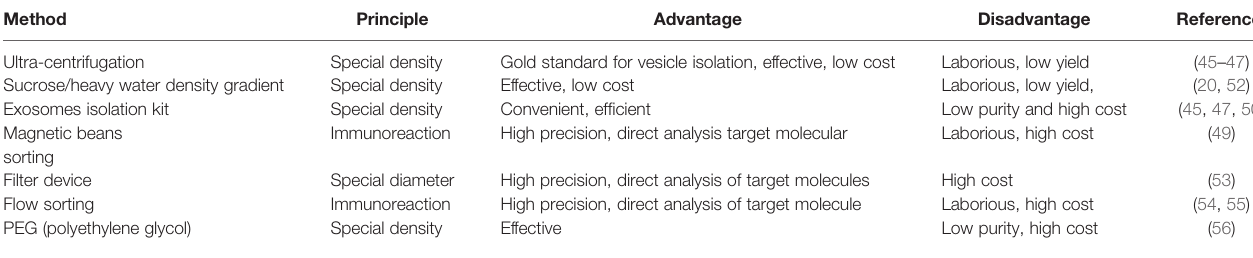
TABLE 1 | Methods of exosome isolation and